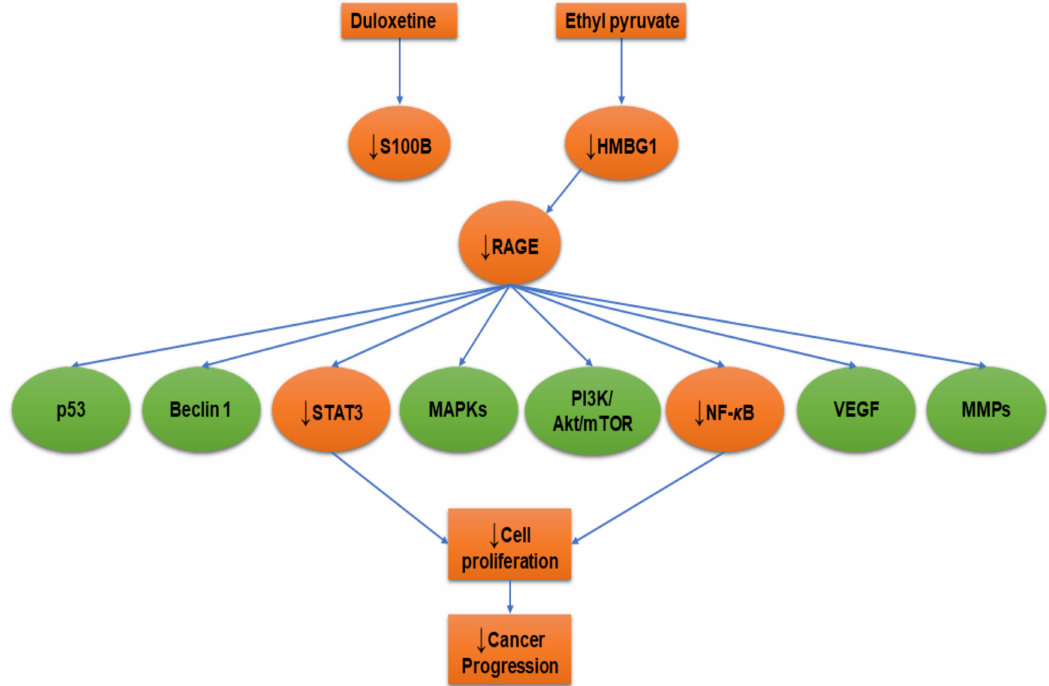
Figure 2. Receptor for advanced glycation end product (RAGE) inhibition with duloxetine and ethyl pyruvate. Orange colored shapes refer to the a ff ected cellular molecules due to RAGE inhibition. The arrow pointing down ( ↓ ) means decrease or